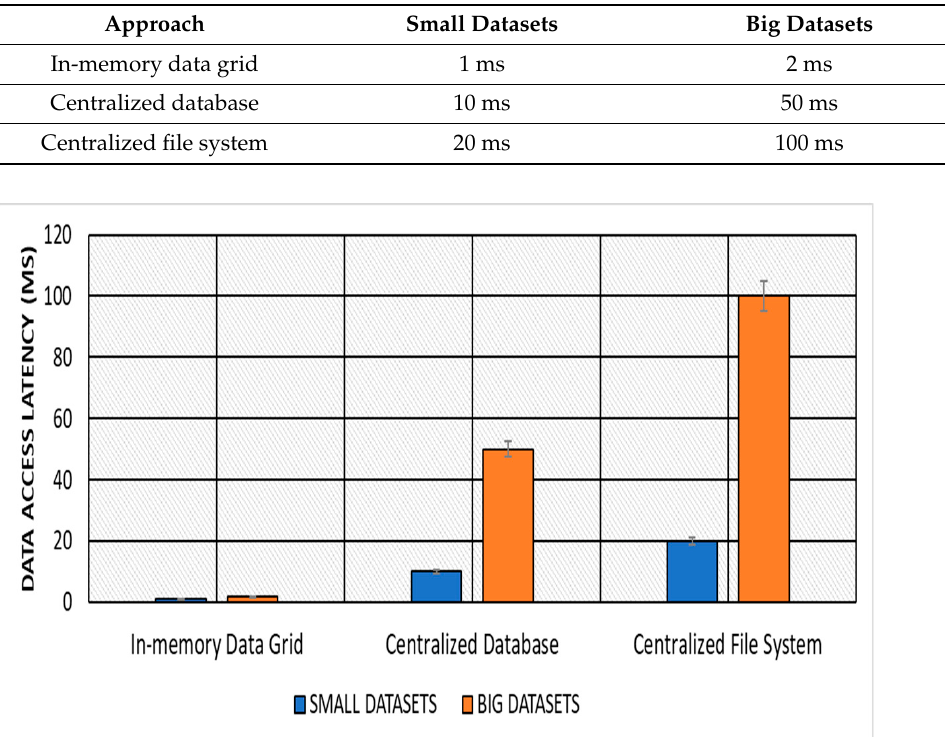
Figure 1. Data access latency performance.